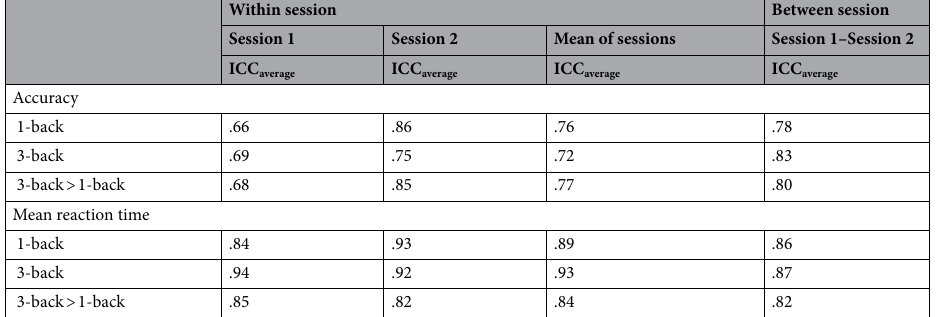
Table 3. Intraclass correlation coefficients (ICCs) of accuracy and mean reaction time. Within-session reliability was indicated by the ICC of a metric among the three task blocks, whereas between-session reliability was represented by the ICC of the overall metric between the two sessions. ICCs of at least 0.40, indicating fair consistency or above, were